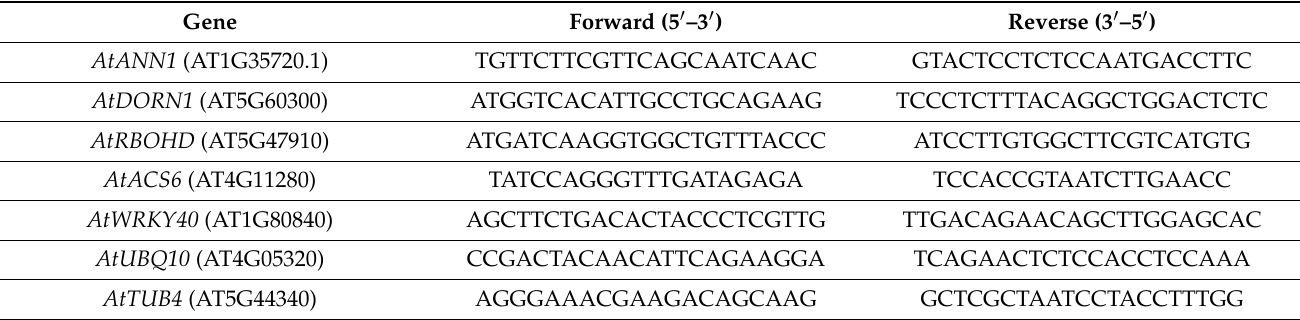
Table 1. The forward and reverse sequences of primers used for the gene expression tests. Gene Forward (5 (cid:48) –3 (cid:48) ) Reverse (3 (cid:48) –5 (cid:48)